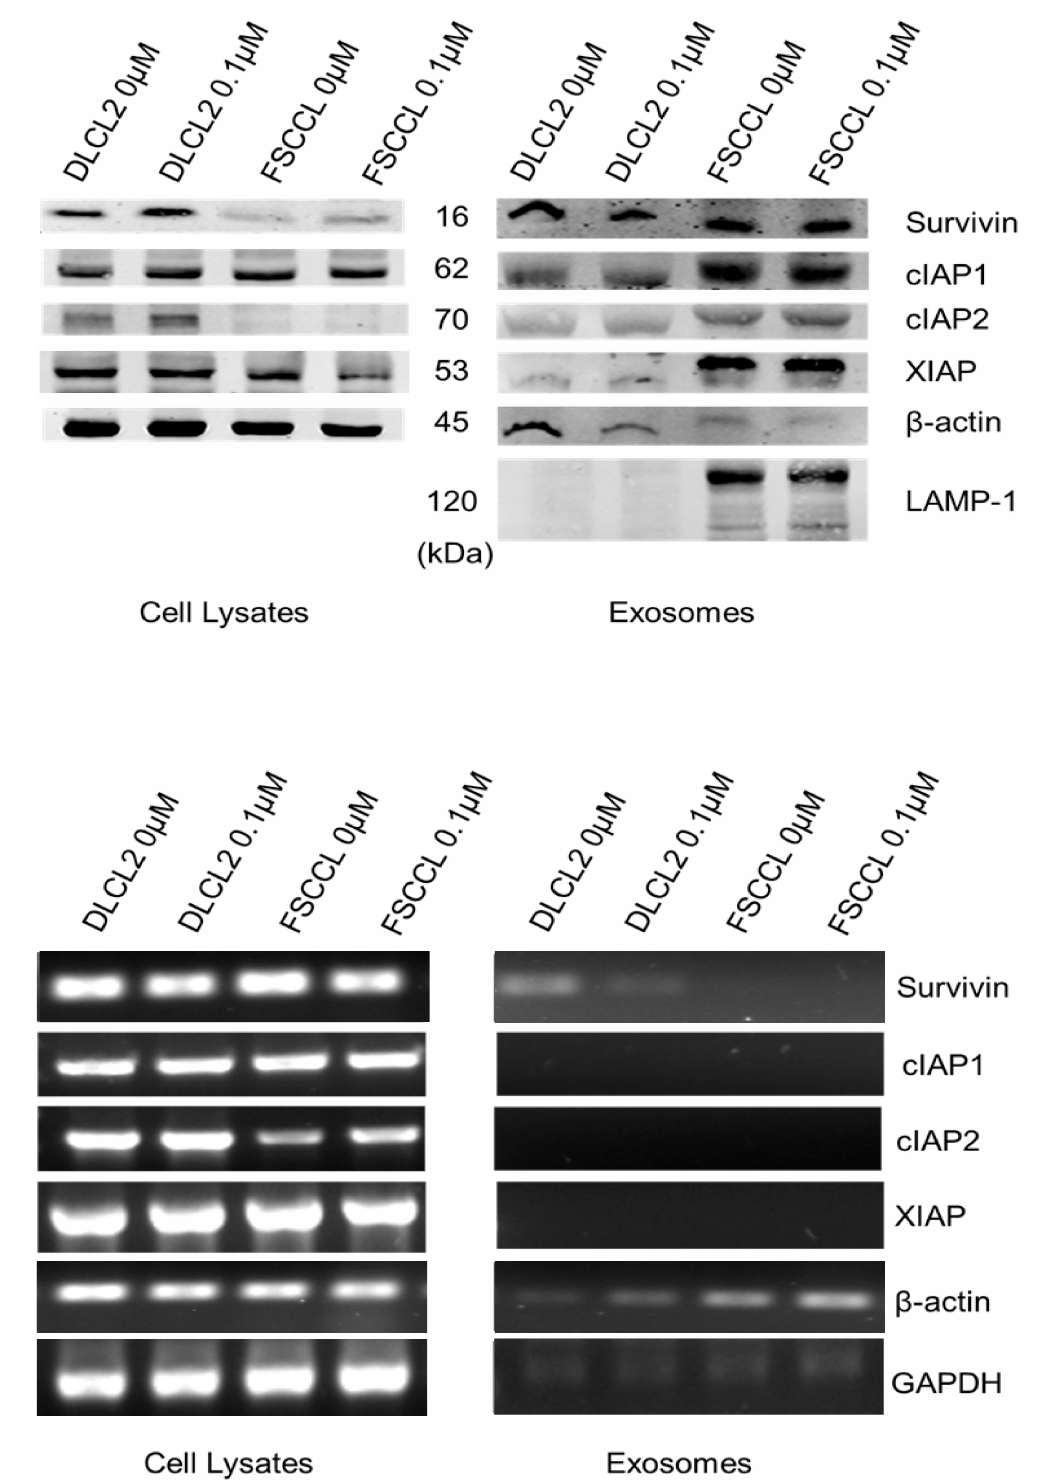
Figure 2. Lymphoma cells and exosomes contain survivin and other inhibitor of apoptosis (IAP) proteins. Cells were treated with sublethal amounts of etoposide (0.1 µ M) for 24 h in order to determine whether stress would change the IAP localization. ( A ) Western blots (30 mg protein) show the IAPs survivin, cIAP1, cIAP2, and XIAP are contained in cell lysates (left) and exosomes (right). GAPDH and β -actin were used as controls. ( B ) RT-PCR analysis of mRNA (200 ng) content in cells and exosomes.